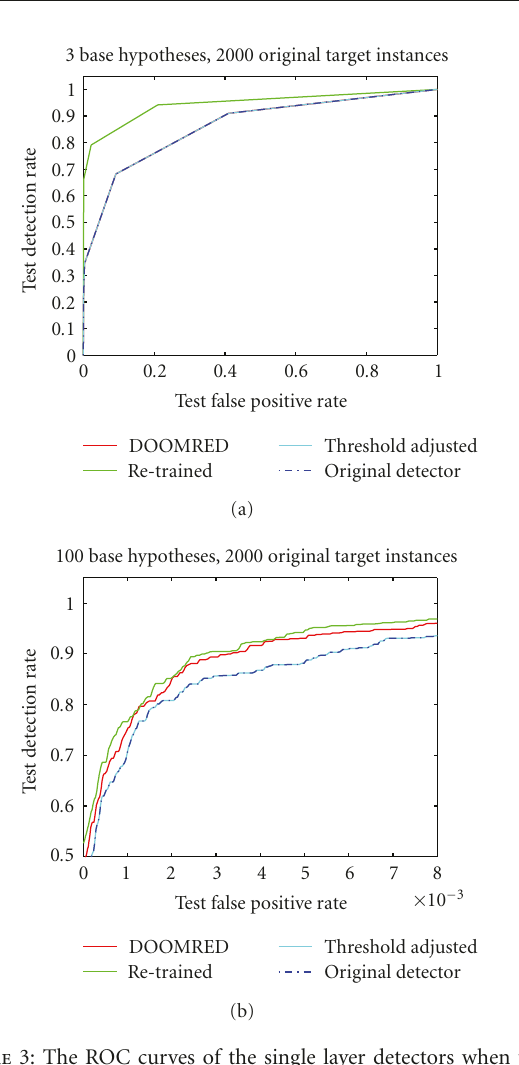
Figure 3: The ROC curves of the single layer detectors when the detector contains (a) 3 (b) 100 (c) 200 base hypotheses.